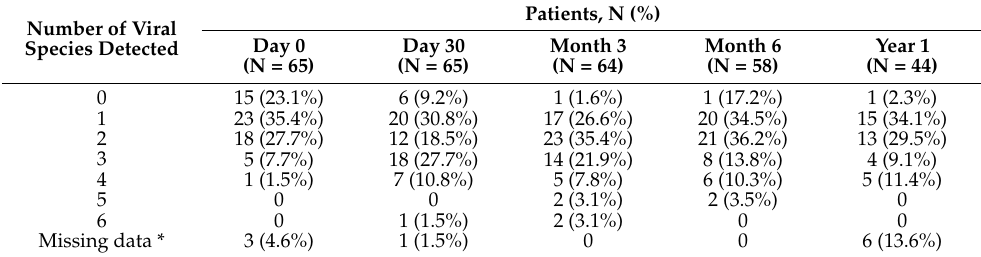
Table 6. Number of viral species detected in plasma samples at each time-point.